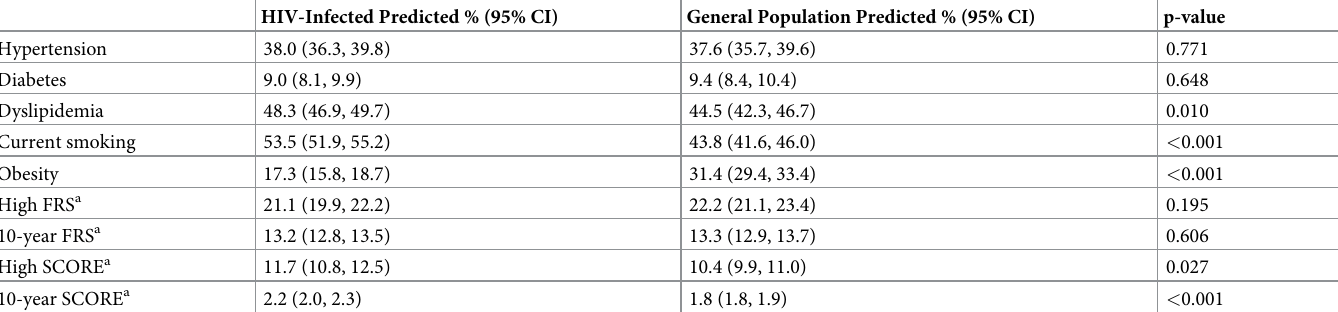
Table 3. Predicted marginal prevalence (for the model that adjusts for age, sex and origin) and 95% confidence interval (CI) of comorbidities and risk factors by HIV status. HIV-Infected Predicted % (95% CI)